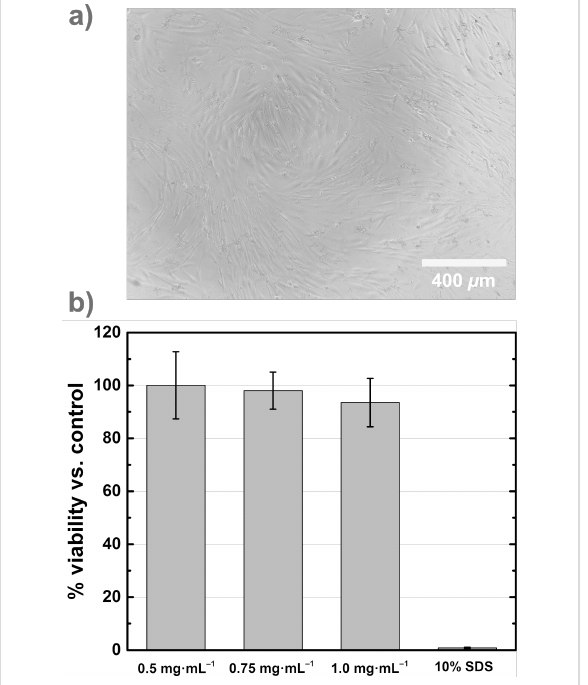
Figure 7: a) Representative microscopic image of hdF 24 h after treat- ment with the NPs ( c = 1 mg·mL − 1 ). b) Cell viability 24 h after adding CaF 2 :(Tb 3+ ,Gd 3+ ) NPs at concentrations between 0.5 and 1 mg·mL − 1 to hdF. 10% SDS was used for the positive control. All samples